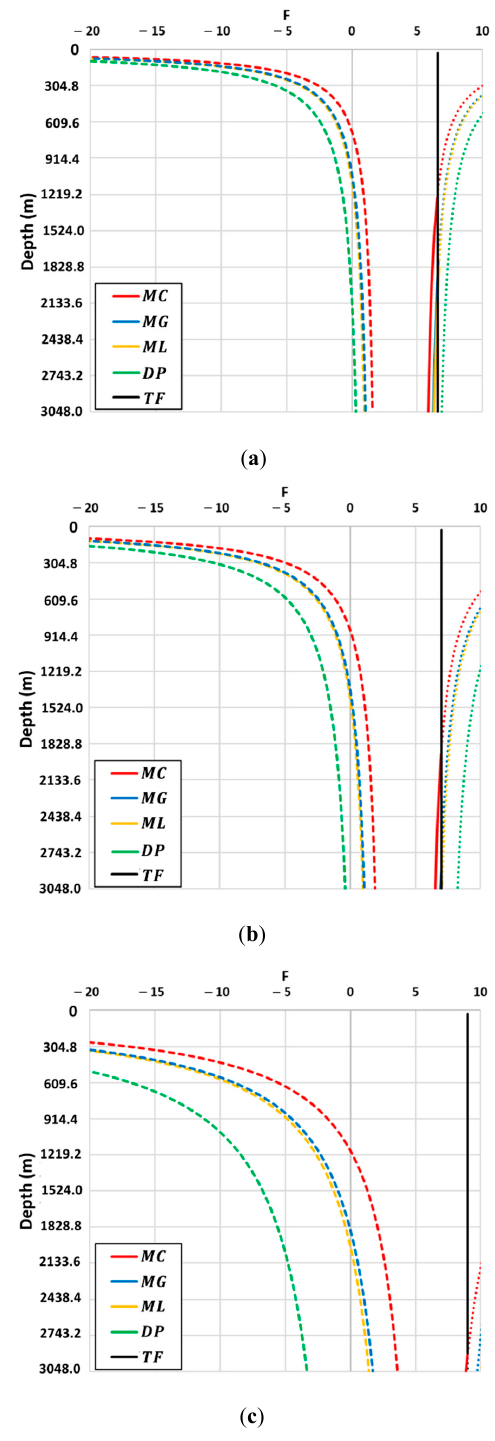
Figure 8. Frac number ( F ) versus depth at failure. F values at lower-bound (colored dashed) and upper-bound shear failure (colored solid) calculated by the Mohr–Coulomb (MC; red), Mogi–Coulomb (MG; blue), modified Lade (ML; yellow), and Drucker–Prager (DP; green) criteria, for the following cases: ( a ) Reverse faulting ( χ 3 = 0.2 ) , ( b ) strike-slip ( χ 2 = 1 ) , and ( c ) normal faulting ( χ 1 = 5 ) . F values at tensile failure (TF; assuming zero tensile strength) are depicted with the black solid line.